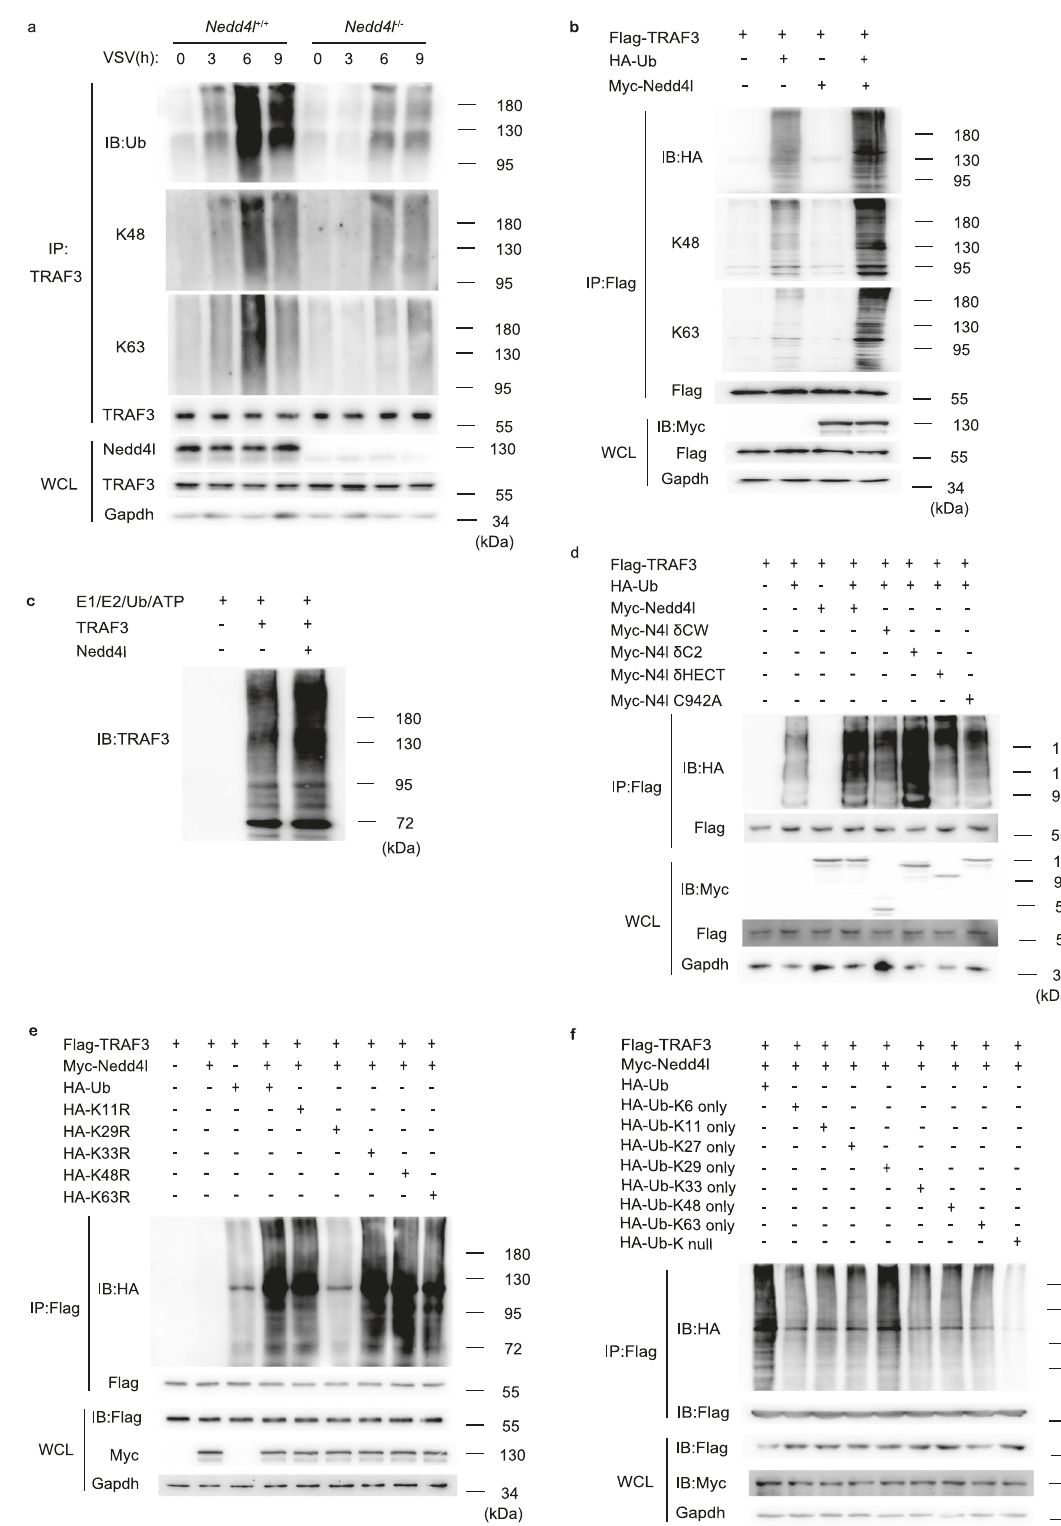
Nedd4l promotes TRAF3 to interact with cIAP1/2 and HECTD3 . TRAF3 is ubiquitinated by other E3 ligases such as cIAP1/2 and HECTD3 12,18 . We examined whether Nedd4l affected the interaction between TRAF3 and these E3 ligases. As shown in Fig. 3b, Nedd4l de fi ciency decreased VSV infection- induced TRAF3-cIAP1/2 and TRAF3-HECTD3